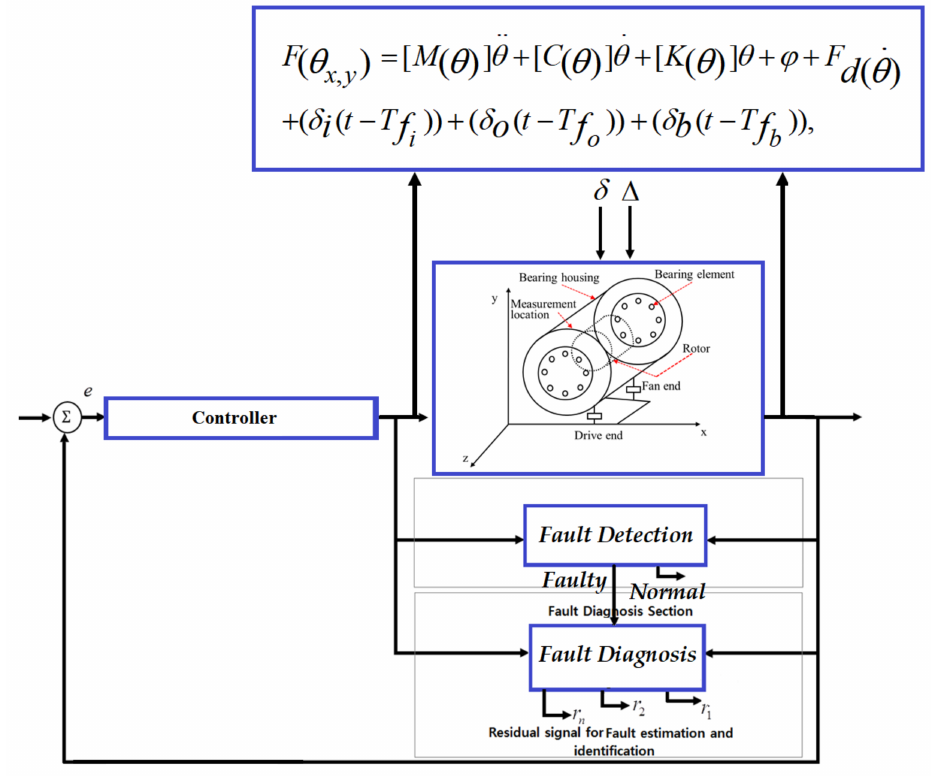
Figure 4. Mathematical modeling of